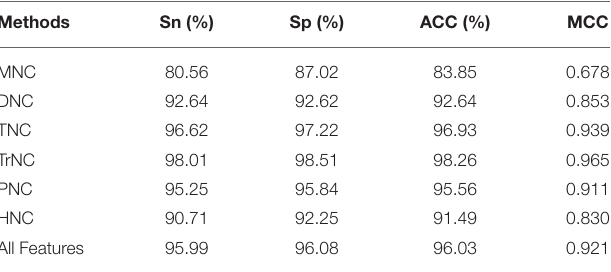
TABLE 1 | The 10-fold cross-validation results by different feature methods on the benchmark dataset. Methods